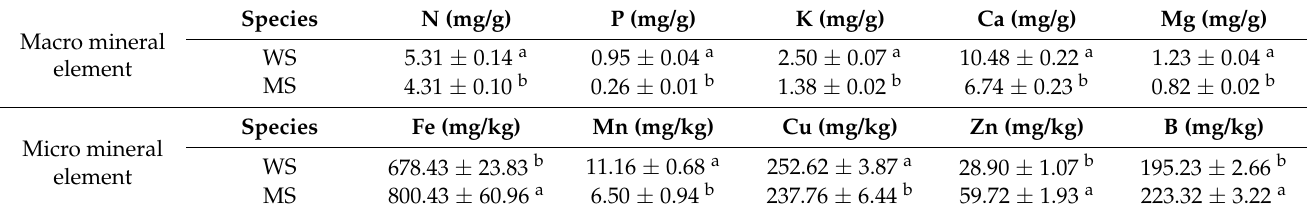
Table 1. Nutritional mineral element content in walnut sawdust and miscellaneous